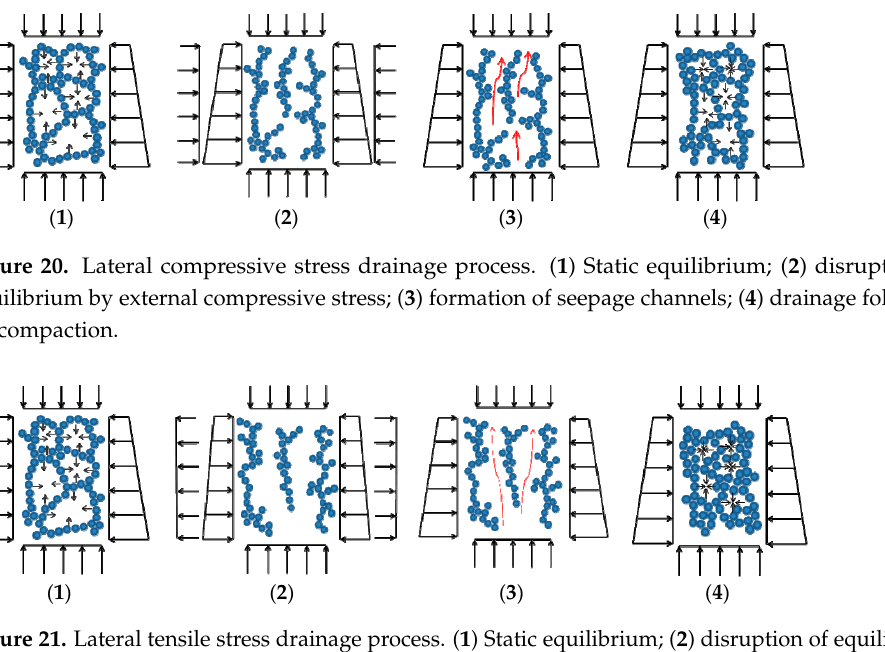
( d ) Figure 19. Effect of agitation on water distribution within the bed. ( a ) Before mixing (uniform distribution); ( b ) after mixing (enrichment into main percolation channel). ( c ) Before microstirring (uniform distribution); ( d ) after microstirring (enrichment into the main seepage channel). The force analysis of the flocs and the percolation process are shown in Figures 20 and 21. The addition of agitation causes the originally unconnected water to connect and